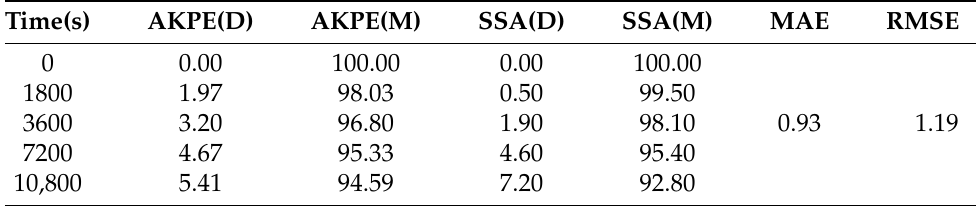
Table 4. Dimer(D) and monomer(M) percentage(%) prediction by AKPE and SSA